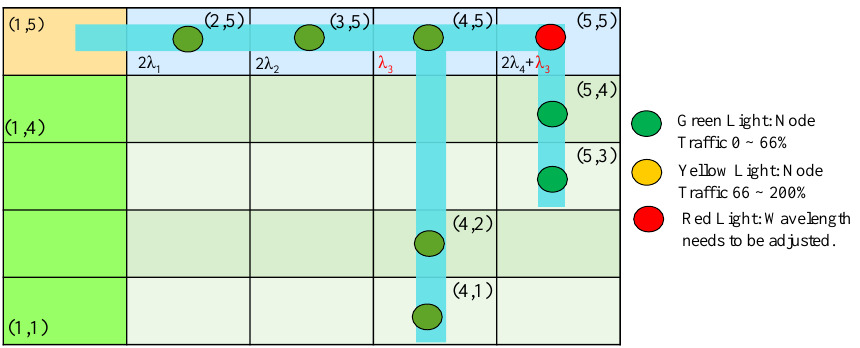
Figure 18. Tra ffi c distribution for Method 2 of two-plane optical tunnel switching network with Figure 18. Traffic distribution for Method 2 of two-plane optical tunnel switching network with 25 25 nodes. nodes.